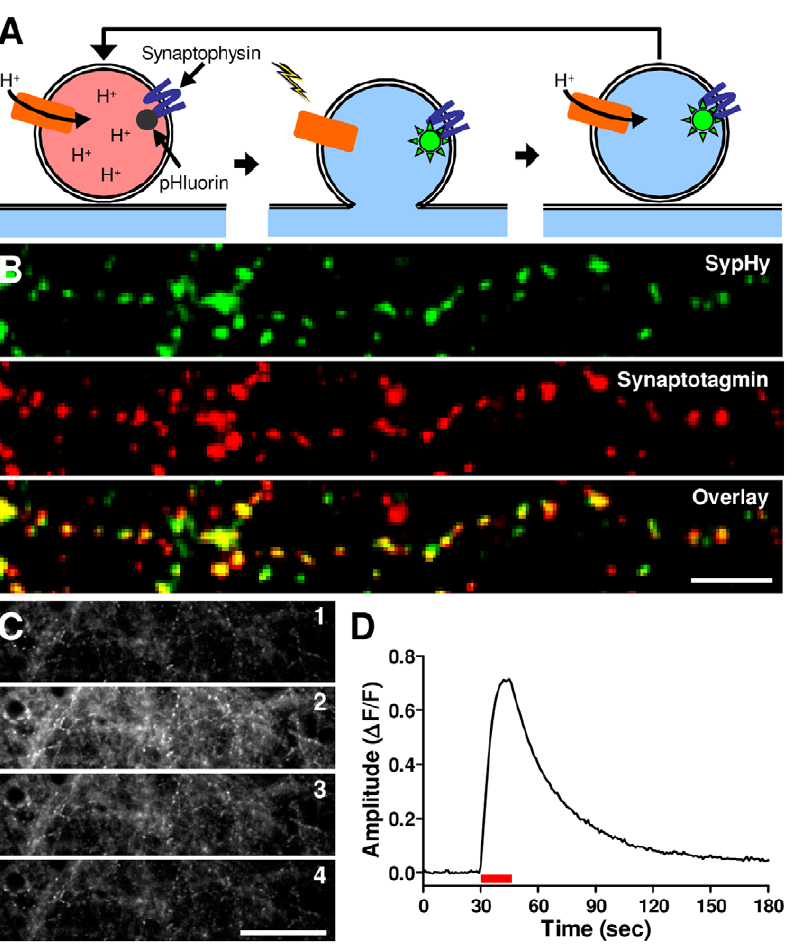
Figure 1. SypHy delivered by AAV transduction as a reporter of presynaptic function. ( A ) Schematic illustrating the function of the sypHy reporter of synaptic vesicle cycling. ( B ) Presynaptic localization of sypHy in neuronal cultures infected with hSyn-sypHy-AAV at 7 days in vitro (DIV) and fixed at 22 DIV shown by colocalization of anti-GFP (green) and anti-synaptotagmin I (red) immunoreactivity. Scale bar: 10 m m. ( C ) Portion of a kinetic fluorescence image series of an hSyn-sypHy-AAV infected culture prior to stimulation (1), during delivery of a 50 Hz, 10 second stimulus train (2), 30 sec after offset of stimulus train (3), and 2 min after offset of stimulus train (4). Scale bar: 50 m m. ( D ) Relative fluorescence intensity of the entire imaging field from the experiment shown in (c). Red bar indicates the stimulus.